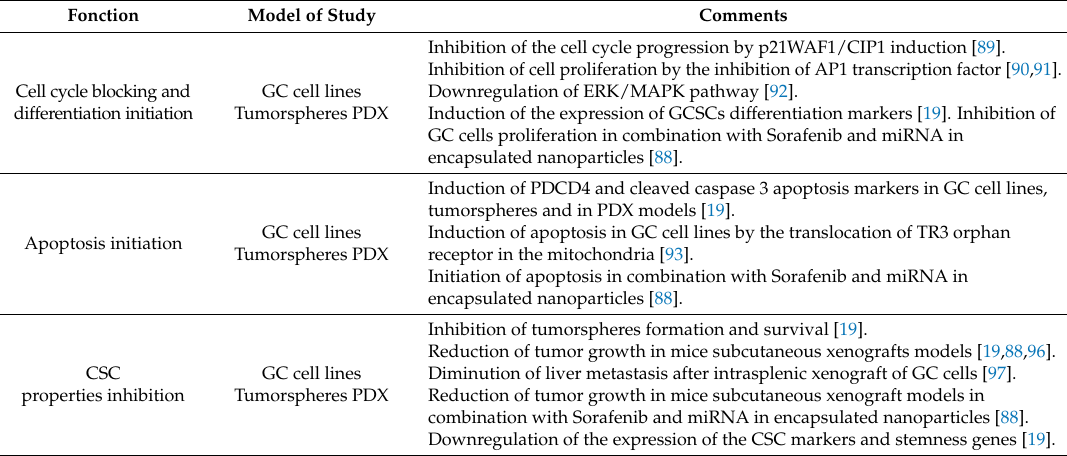
Table 2. All-trans retinoic acid (ATRA)’s anticancer mechanisms of action against GC cells.